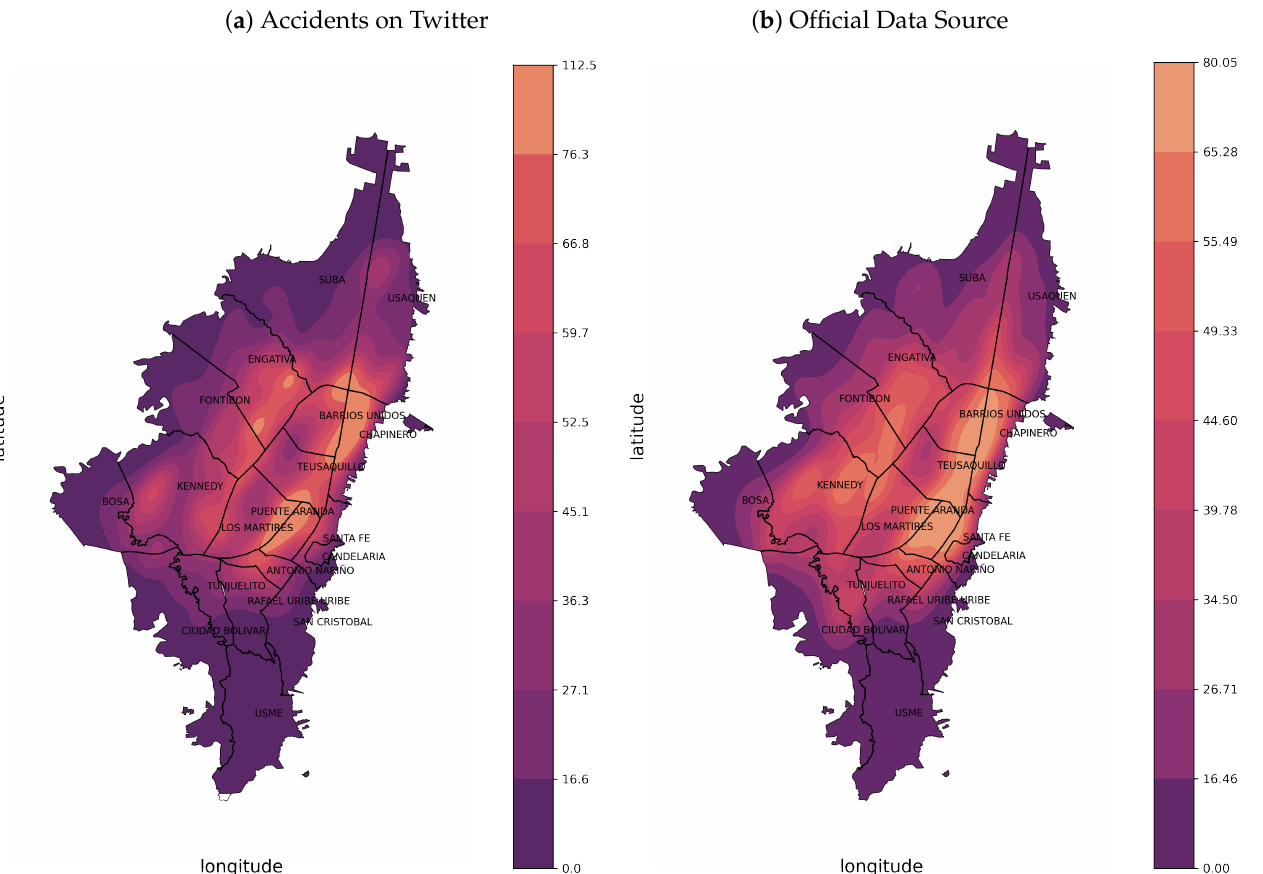
Figure 8. Geographical incidence of accidents reported from October 2018 to July 2019 according to data on Twitter ( a ) and Official Source ( b